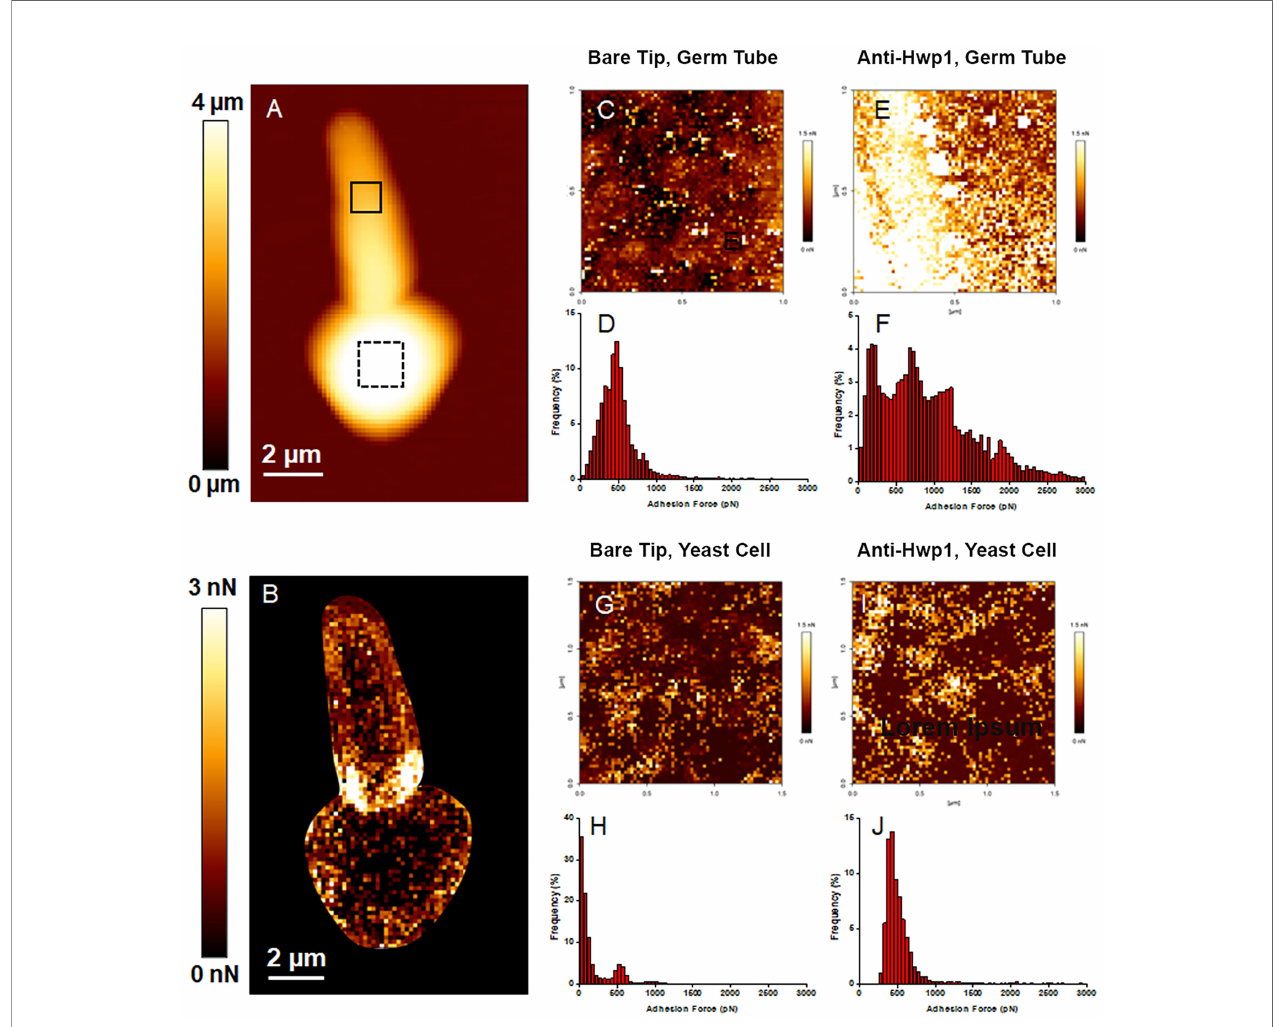
FIGURE 3 | AFM analysis of a C. albicans CAI12 germ tube. (A) The AFM height image recorded in Quantitative Imaging mode with a color scale to indicate the contact point height (z range), which is the vertical coordinate where the AFM tip touches the cell surface. The image shows the relief of the yeast and germ tube surfaces with lighter color indicating higher points and darker color indicating lower points. (B) The adhesion map of the same cell recorded with a bare AFM tip with a color scale to indicate the adhesion force range. Lighter color indicated a higher occurrence of non-speci fi c adhesive events. These regions were avoided in subsequent experiments to record the adhesion maps. (C) The adhesion map, recorded with a bare AFM tip, of the 1 m m x 1 m m solid square on the germ tube surface in (A) . (D) Repartition of the maximum adhesion measured on the 4096 force curves corresponding to the map in (C) . (E) The adhesion map, recorded with the anti-Hwp1 functionalized AFM tip, of the 1 m m x 1 m m solid square on the germ tube surface in (A) . (F) Repartition of the maximum adhesion measured on the 4096 force curves corresponding to the map in (E) . (G) The adhesion map, recorded with a bare AFM tip, of the 1.5 m m x 1.5 m m dashed square on the yeast cell surface in (A) . (H) Repartition of the maximum adhesion measured on the 4096 force curves corresponding to the map in (G) . (I) The adhesion map, recorded with the anti-Hwp1 functionalized AFM tip, of the 1.5 m m x 1.5 m m dashed square on the yeast cell surface in (A) . (J) Repartition of the maximum adhesion measured on the 4096 force curves corresponding to the map in (I)